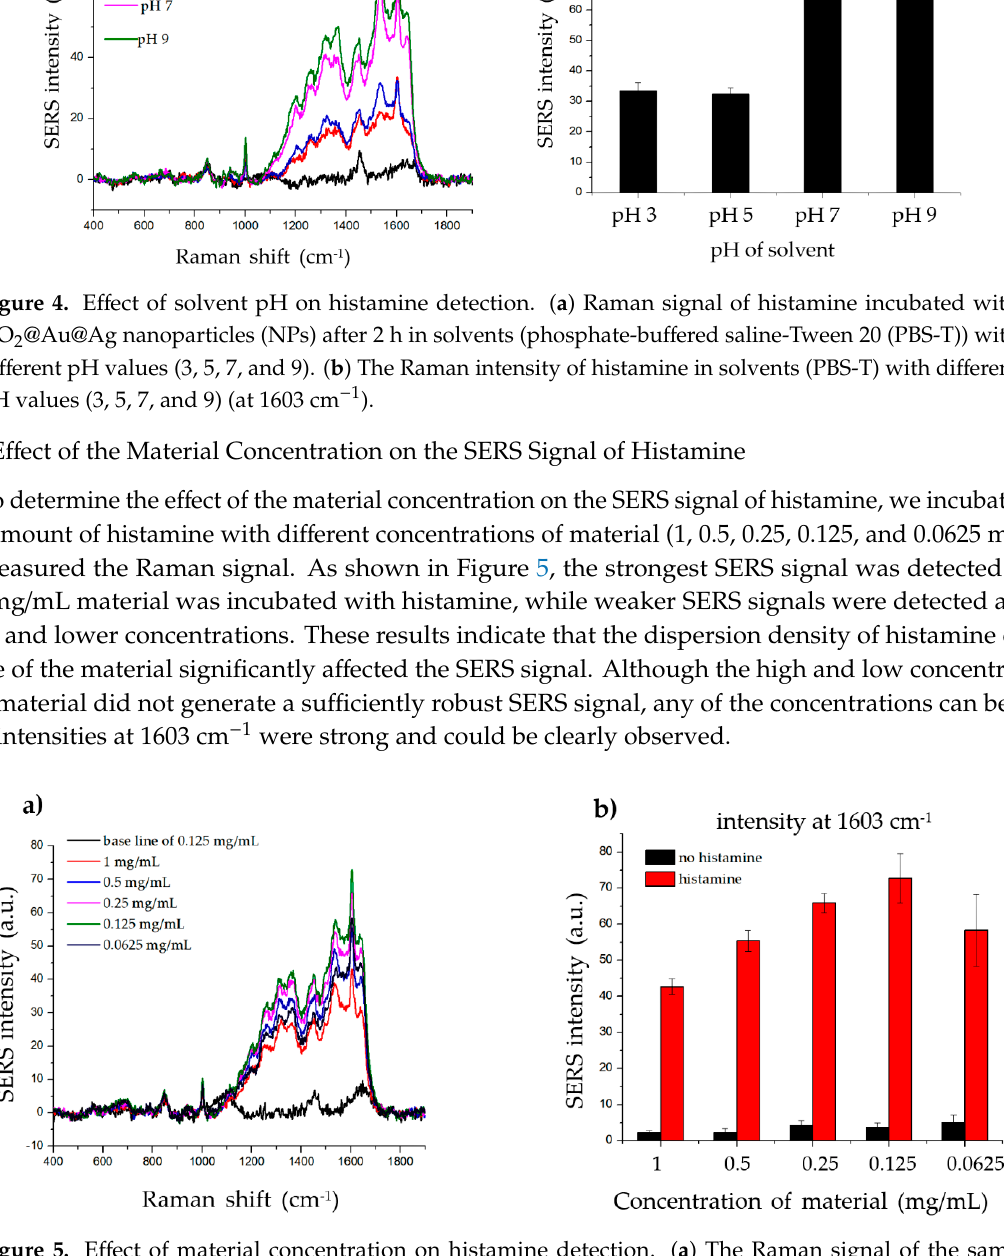
Figure 5. E ff ect of material concentration on histamine detection. ( a ) The Raman signal of the same concentration of histamine incubated with 1, 0.5, 0.25, 0.125, and 0.0625 mg / mL of SiO 2 @Au@Ag nanoparticles (NPs). ( b ) The Raman intensity of histamine for di ff erent concentrations of SiO 2 @Au@Ag NPs (at 1603 cm − 1